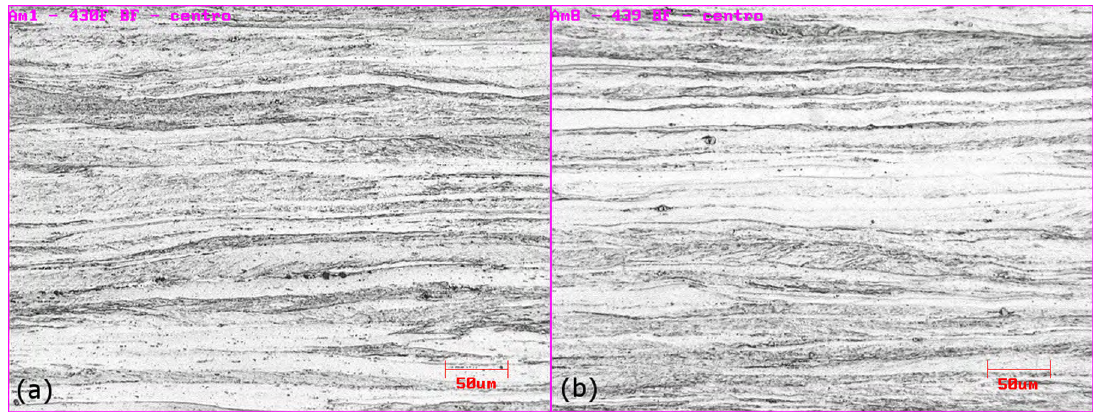
possible to identify any changes in microstructure analyzed by optical